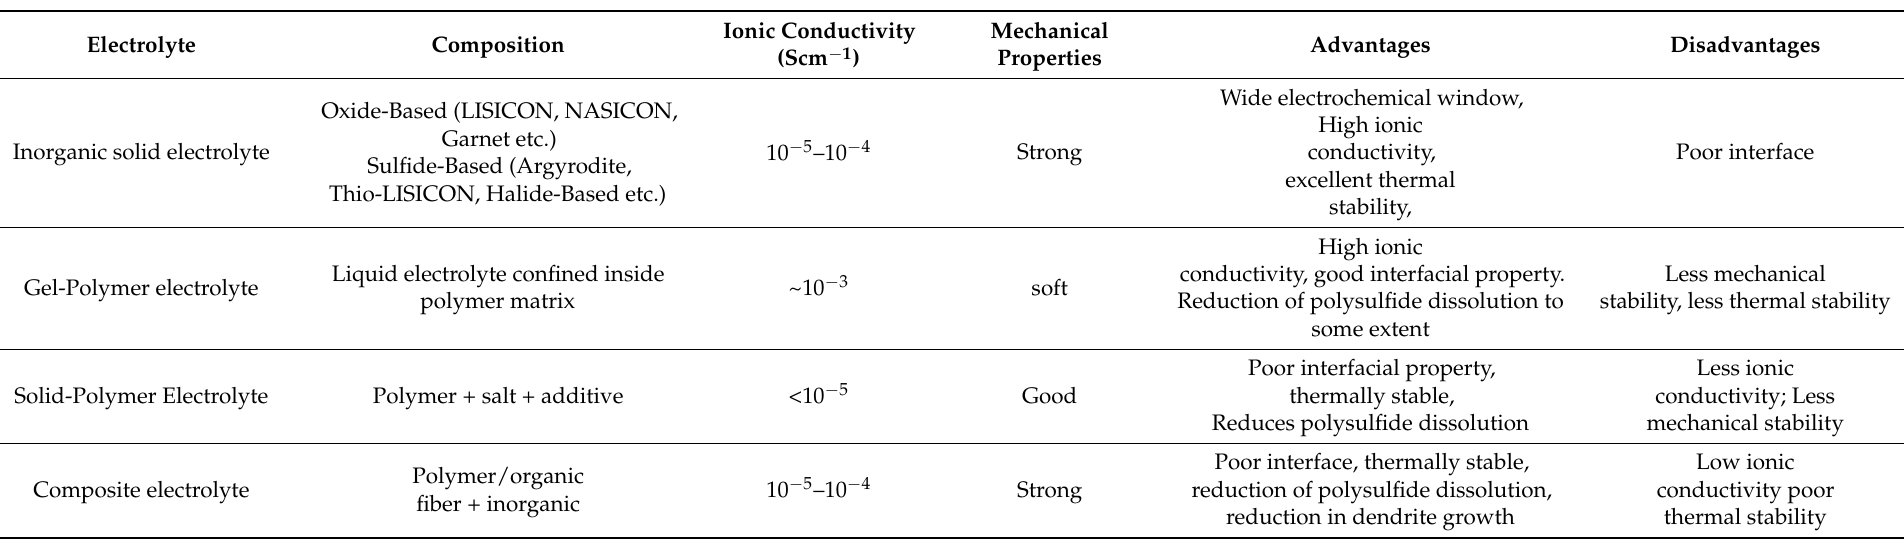
Table 1. Comparative study of different electrolyte systems discussed in the present review. Reprinted with permission from